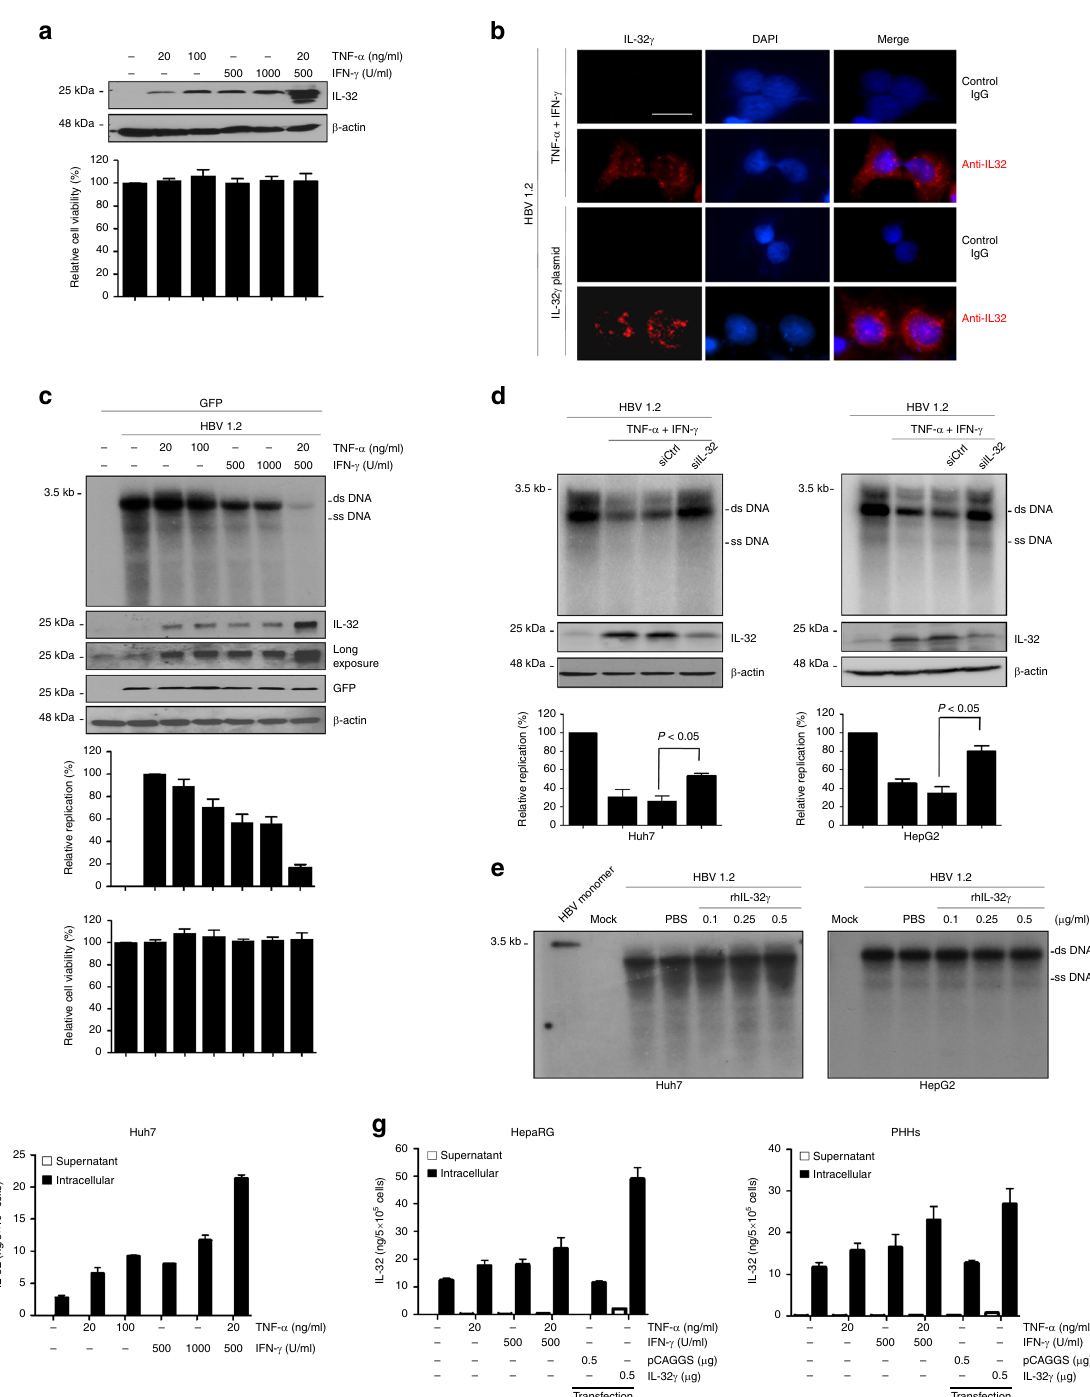
Fig. 1 Induction of IL-32 is involved in cytokine-mediated inhibition of HBV. a Huh7 cells were treated with the indicated concentrations of TNF- α and IFN- γ for 48 h, and the IL-32 level was determined by western blot analysis. Relative cell viability was measured by the XTT method. b Expression of IL-32 γ induced by cytokines or transient transfection was observed by immuno fl uorescence assay. Magni fi cation, ×400; scale bar, 50 μ m. c Huh7 cells were transfected with the HBV 1.2 and GFP plasmids and treated with TNF- α and IFN- γ . HBV replication was determined by Southern blotting. Expression levels of IL-32 and GFP (transfection control) were determined by western blotting. d HBV 1.2 and siRNAs (20 nM) were co-transfected into Huh7 or HepG2 cells. Next day, cytokines were added with fresh medium. HBV replication and IL-32 expression were determined by Southern and western blotting, respectively. p < 0.05 by Student ’ s t -test. e Huh7 or HepG2 cells were transfected with the HBV 1.2 plasmid and treated with recombinant human IL-32 γ (rhIL-32 γ ) for 3 days. HBV replication was determined by Southern blotting. f The levels of the IL-32 protein in culture medium and lysates of cytokine- treated Huh7 cells were determined by ELISA. The total amount of secreted (supernatant) or intracellular IL-32 in whole cells grown in a 12-well plate are shown. g The levels of the IL-32 protein in culture medium and lysates of cytokine-treated PHHs and differentiated HepaRG cells were determined by ELISA. Dashed bars represent the level of IL-32 obtained after transfection with pCAGGS (control) or IL-32 plasmids. Data ( a , c , d , f , g ) were obtained from three independent experiments (mean ± S.D.). p < 0.05 by Student ’ s t -test NATURE COMMUNICATIONS| (2018) 9:3284 |DOI: